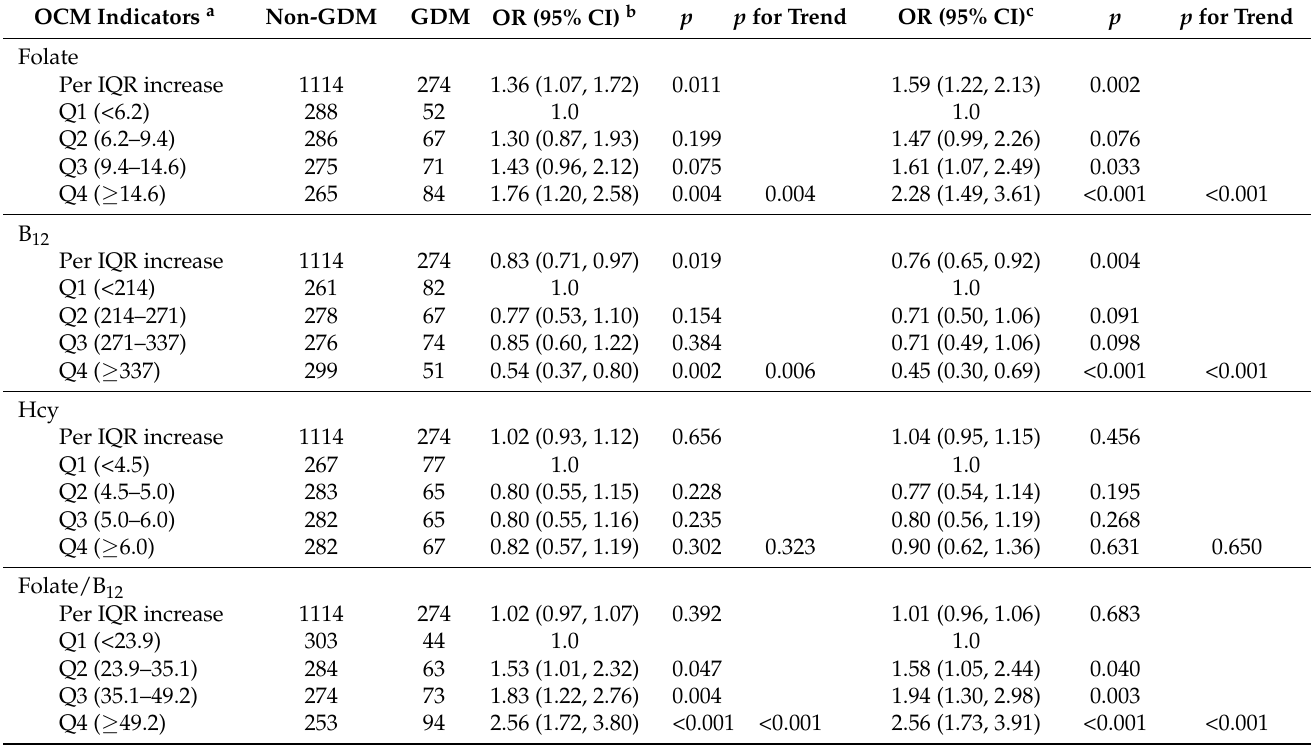
Table 2. Odds ratios of OCM indicators for GDM ( n =